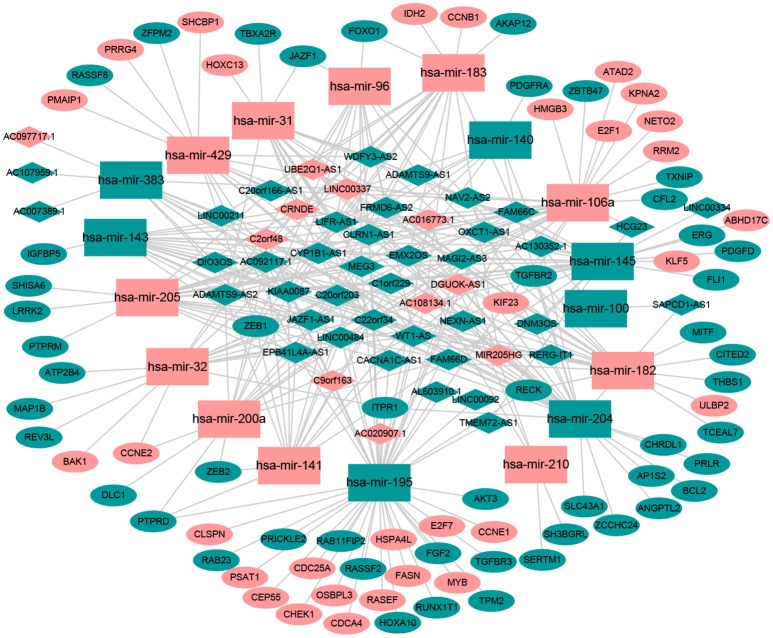
The ceRNA network of lncRNA-miRNA-mRNA. Green diamonds represent downregulated lncRNA, red diamonds indicate upregulated lncRNA, green rectangles indicate downregulated miRNA, red rectangles indicate upregulated miRNA, green ellipses indicate downregulated mRNA, and red ellipses indicate upregulated mRNA.